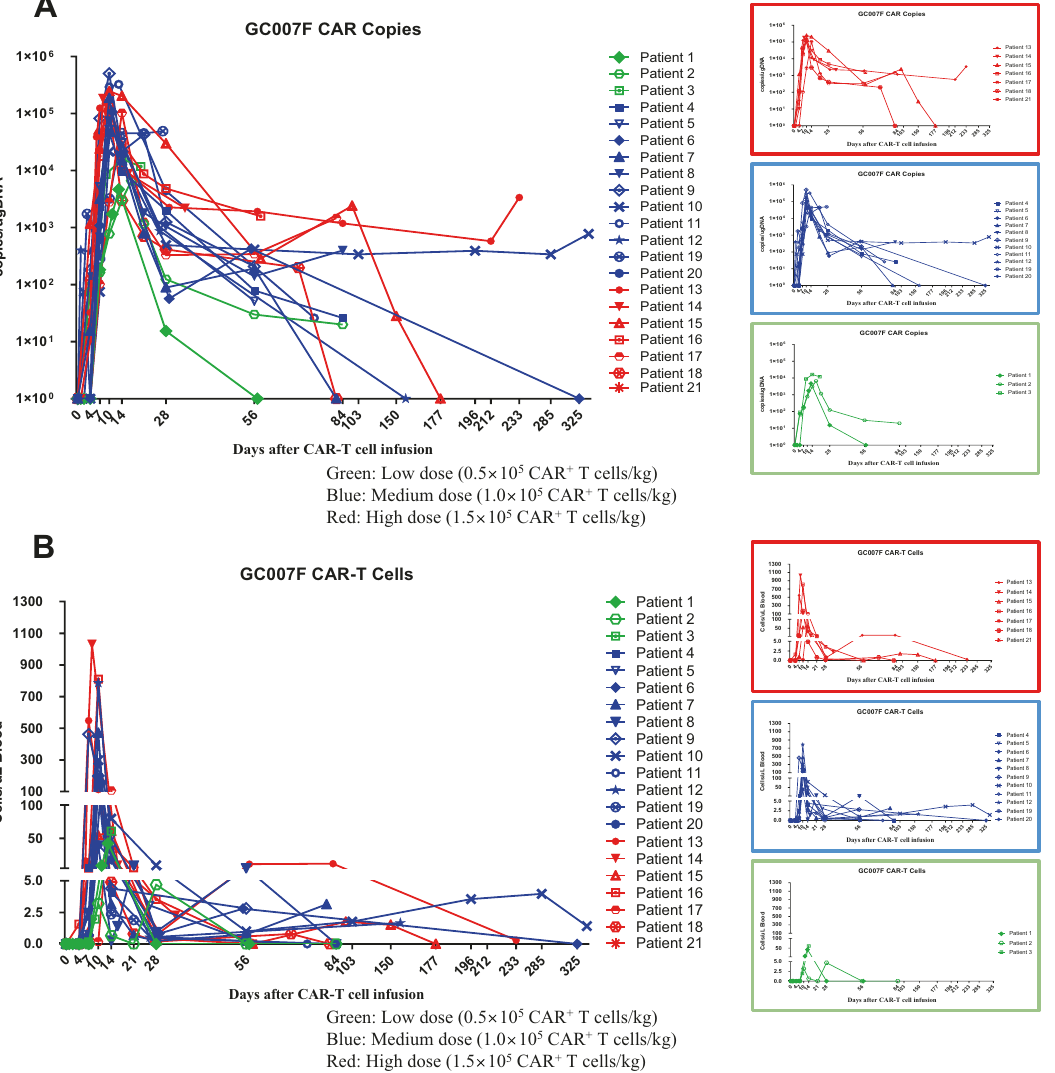
Fig. 4 The persistence of CAR-T cells in the peripheral blood of patients enrolled in the clinical study ( n = 21) was evaluated using qPCR and fl ow cytometry. Peripheral blood mononuclear cells (PBMCs) were obtained from enrolled patients with R/R B-ALL. The patients underwent conditioning according to their disease burden. GC007F cells were infused after 24 – 48 h of conditioning. After GC007F cell infusion, PBMCs were collected to analyze cell pharmacokinetics on days 4, 7, and 10 and weeks 2, 4, 8 and 12. Three doses of GC007F cells (dose level (DL) 1 (green): 0.5 × 10 5 CAR + T cells/kg, DL2 (blue): 1.0 × 10 5 CAR + T cells/kg, and DL3 (red): 1.5 × 10 5 CAR + T cells/kg) were used in this study. A The CAR copies/µg DNA of GC007F cells was detected using qPCR. B The numbers of CAR + (GC007F) cells were detected using fl ow